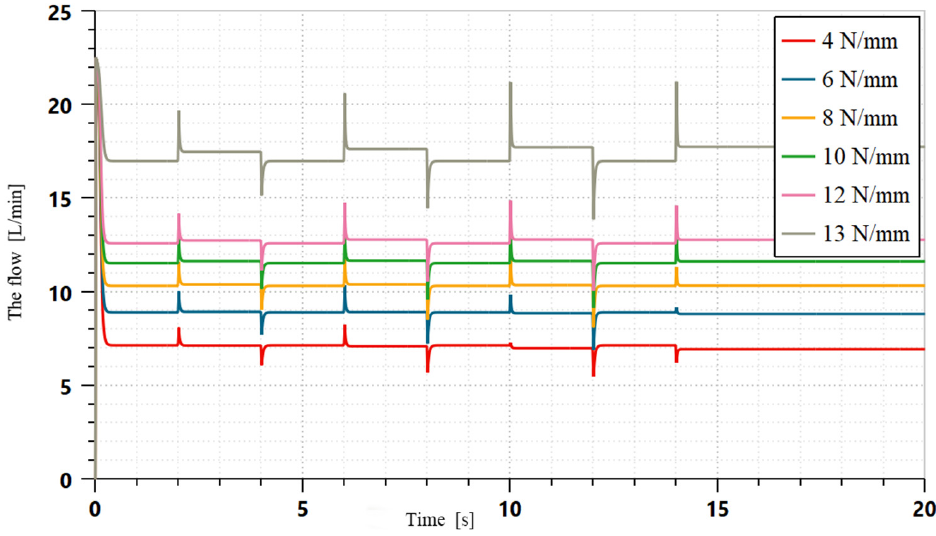
Figure 11. Flow-rate change in spring stiffness from 4 N/mm to 12 N/mm.